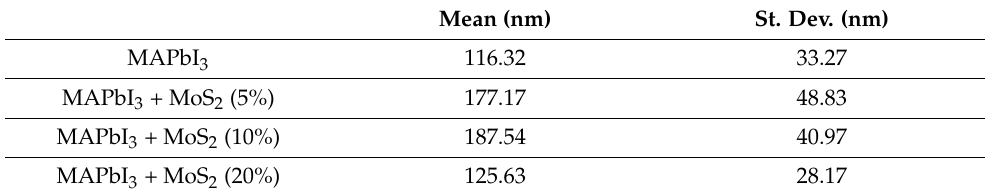
Figure 4. Particle size distribution histograms of the as-prepared MAPbI 3 perovskite films, with and without MoS 2 additive: ( a ) MAPbI 3 ; ( b ) MAPbI 3 + MoS 2 (5%); ( c ) MAPbI 3 + MoS 2 (10%); ( d ) MAPbI 3 + MoS 2 (20%). Table 2. Statistical analysis for the MAPbI 3 grain size, with and without MoS 2 additive.